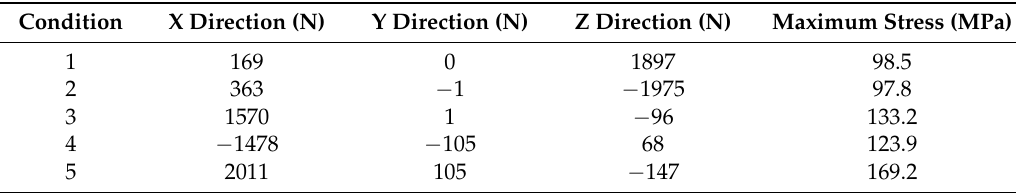
Table 1. Typical working load.